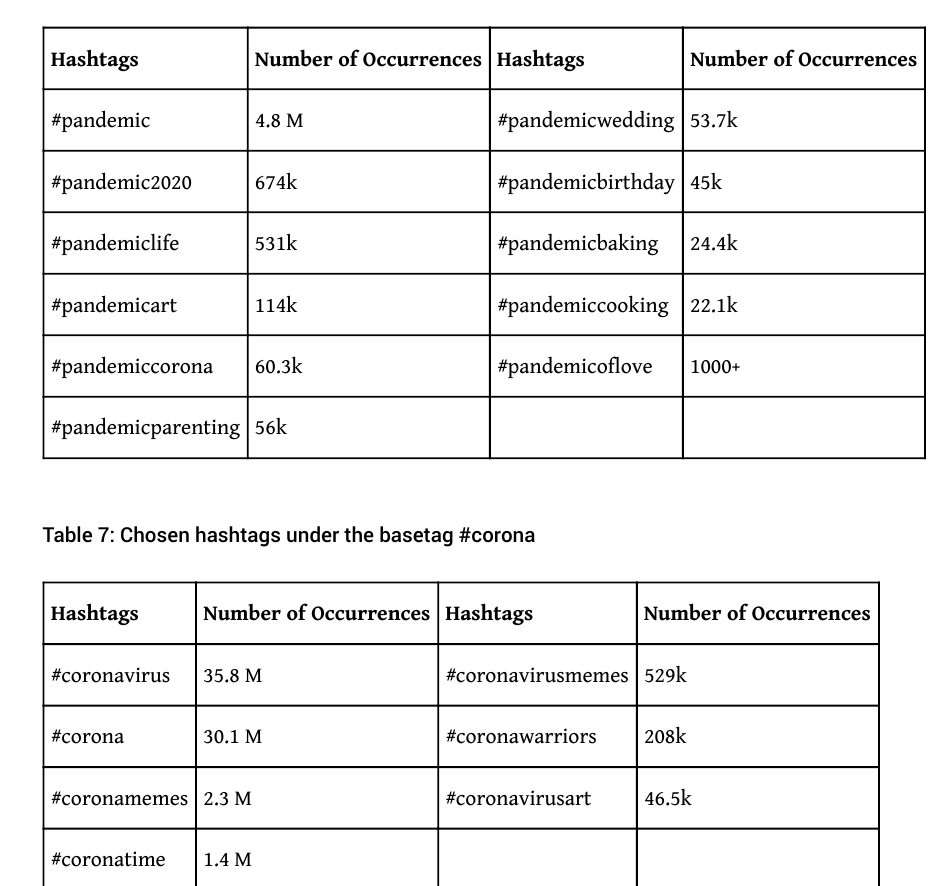
Table 6: Chosen hashtags under the basetag #pandemic